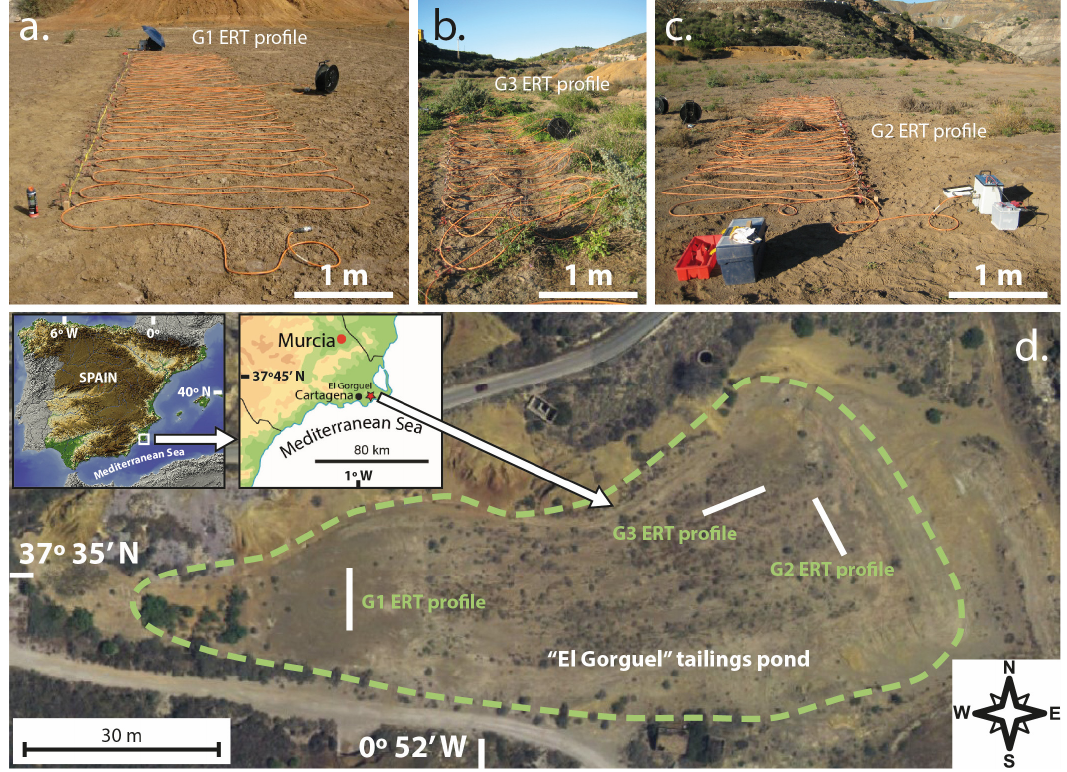
Figure 1. Location of the study area and detailed view of the electrical resistivity tomography (ERT) profile G1 ( a ), G2 ( b ), and G3 ( c ) and their position on the tailing pond ( d ).